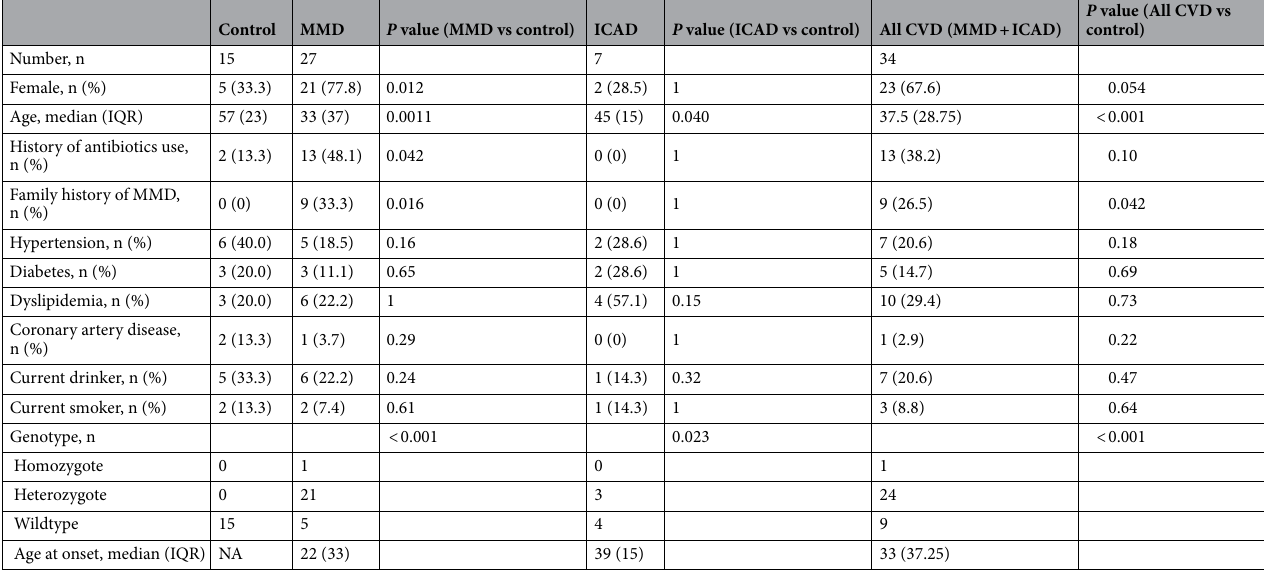
Table 1. Characteristics of the Study Population. MMD represents moyamoya disease; ICAD, non-moyamoya intracranial large artery disease; CVD, cerebrovascular disease; NA, not applicable; IQR, interquartile range. All CVD consists of MMD and